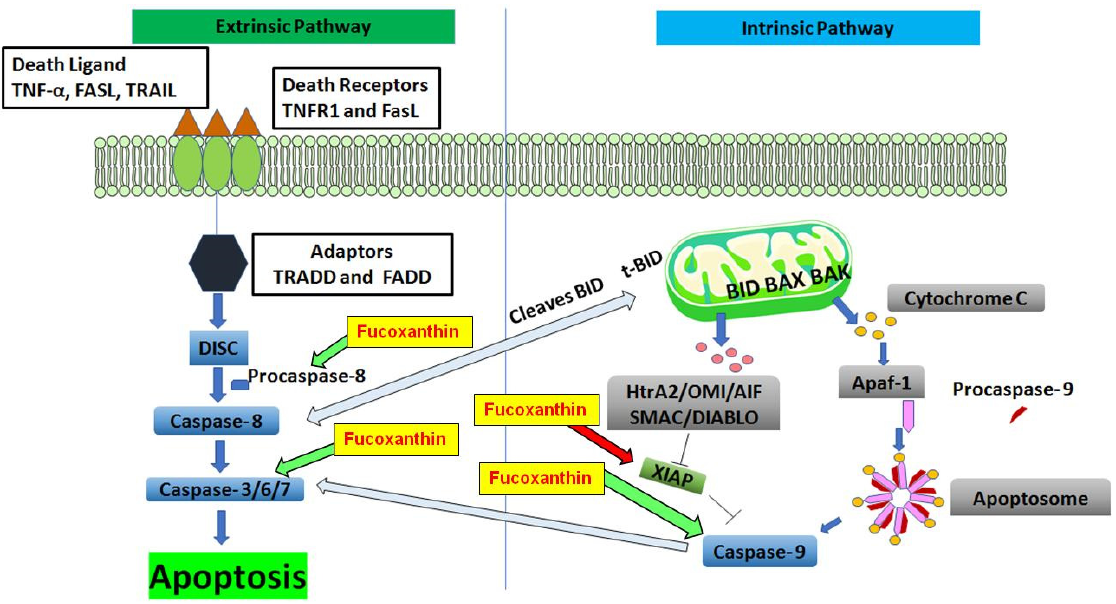
Figure 4. The proposed effect of fucoxanthin on the extrinsic (death receptor) and intrinsic (mito- chondrial) pathways of apoptosis. Red arrows indicate that inhibition is induced by fucoxanthin, and green arrows indicate activation is induced by fucoxanthin.